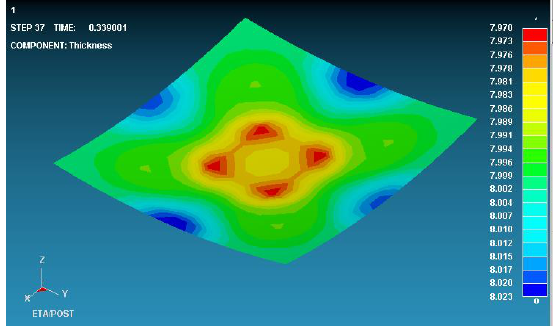
Figure 6. Contour map of thickness change.